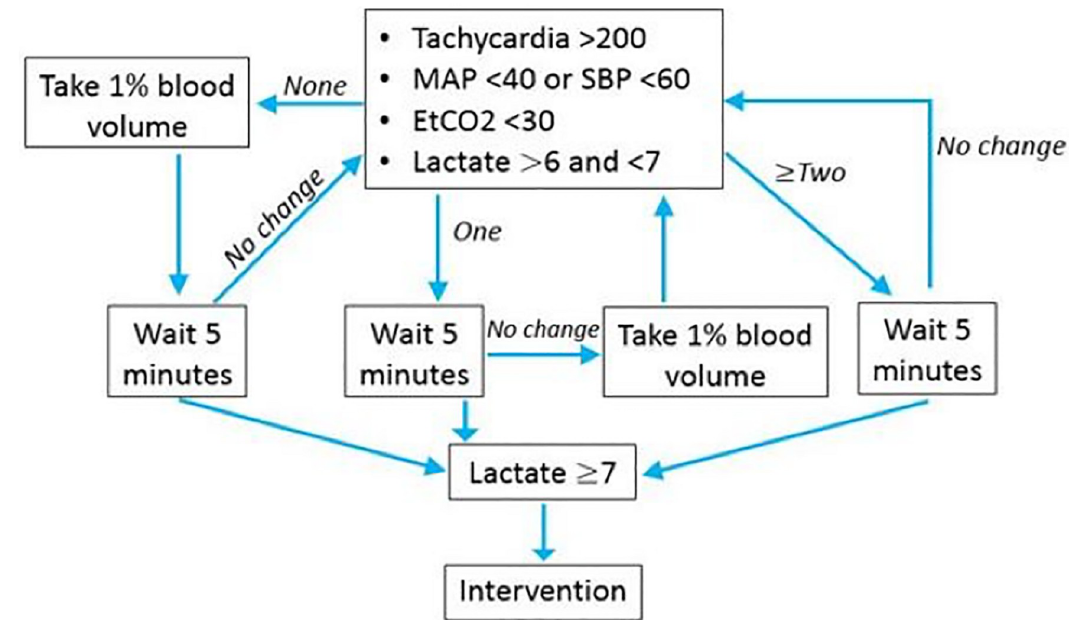
Fig 1. Hemorrhage algorithm. Algorithm utilized following hemorrhage of 35% blood volume to achieve lactate of 7 and hemodynamic instability.